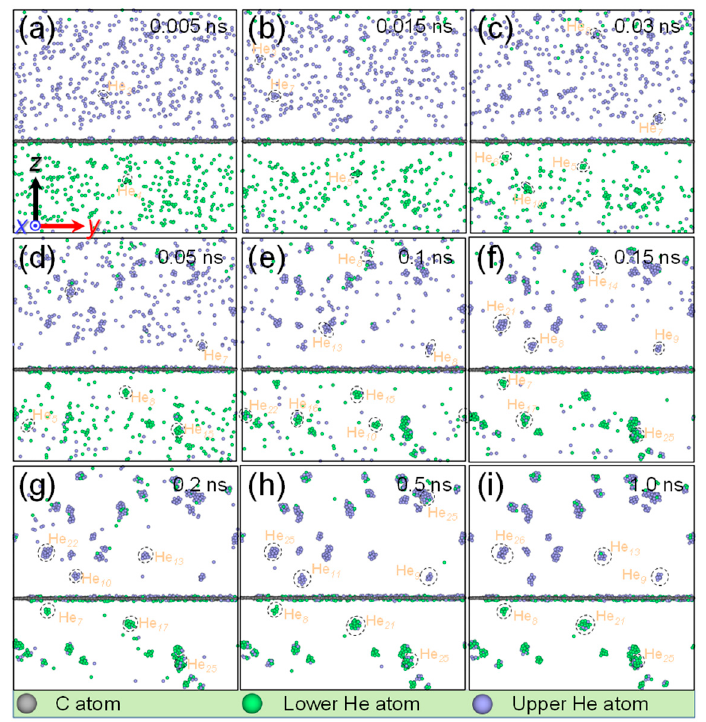
Figure 8. Snapshots of He diffusion near the defective NGI at the times of 0.005 ( a ), 0.015 ( b ), 0.03 ( c ), 0.05 ( d ), 0.1 ( e ), 0.15 ( f ), 0.2 ( g ), 0.5 ( h ), and 1.0 ns ( i ). 0.05 ( d ), 0.1 ( e ), 0.15 ( f ), 0.2 ( g ), 0.5 ( h ), and 1.0 ns ( i